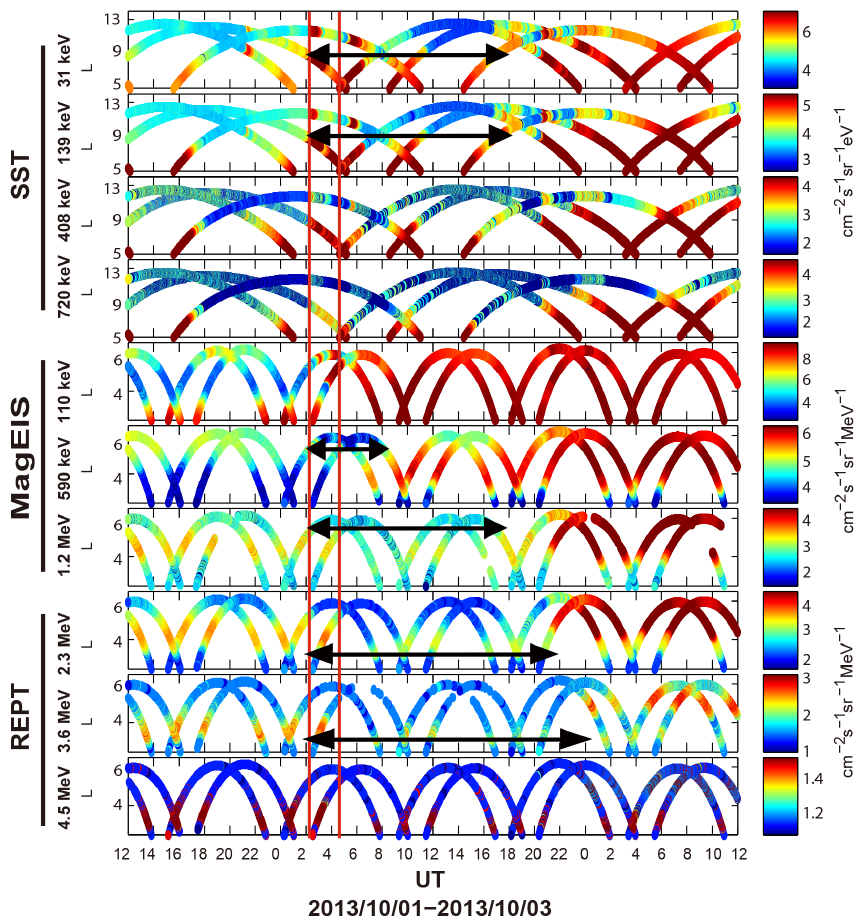
Figure 6. Temporal variations of radiation belt electron flux observed by the SST instrument onboard THEMIS A, D, E from L = 5 to L = 14 and the MagEIS and REPT instrument onboard Van Allen Probes between L = 2 . 5 and L = 6 . 5 during the 2-day period for the indicated 10 energy channels. The two vertical lines represent the start of the two intense P dyn enhancements. The color scale specifies the logarithmic values of electron